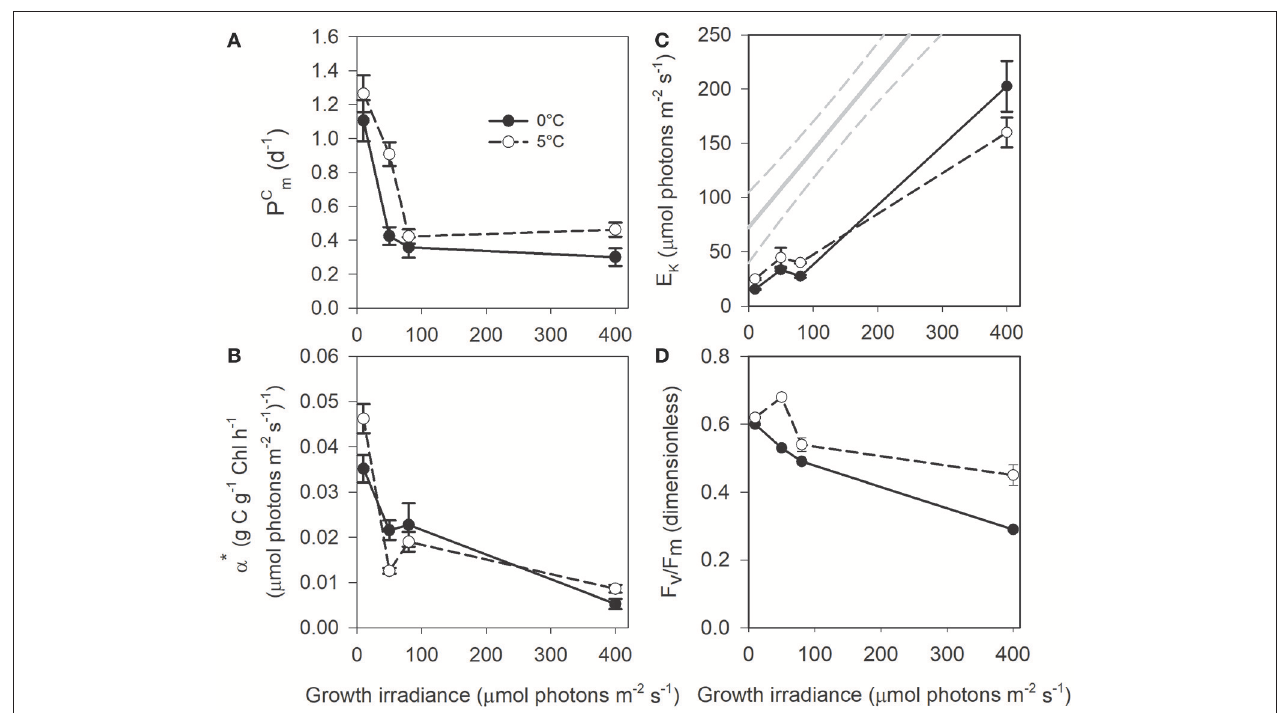
FIGURE 3 | (A) P C m , (B) α * , (C) E K , and (D) F v /F m as a function of growth irradiance in T. gravida cells acclimated to 0 ◦ C (closed circles) and 5 ◦ C (open circles). See Table 1 for parameters definition. Each data point is the mean of 3 independent cultures, error bars represent standard deviations. In (C) , the continuous gray line represents the relationship between E K and growth irradiance in temperate diatoms as computed by Lacour et al. (2017), 95% confidence bands are plotted as dotted lines.